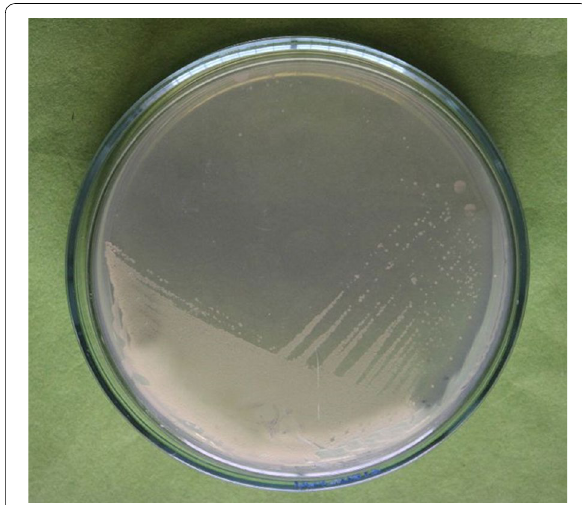
Fig. 1 Photograph of the bacteria growth